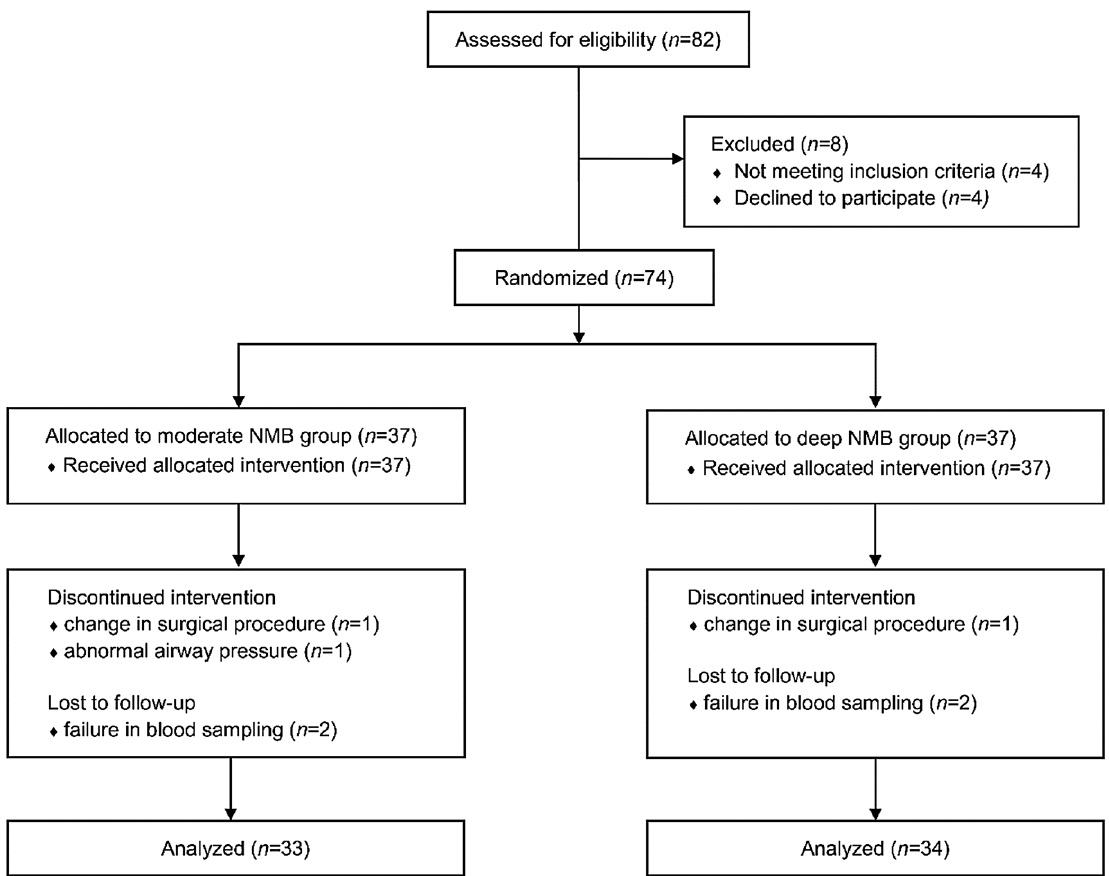
Figure 1. Patient allocation diagram. Abbreviations: NMB neuromuscular